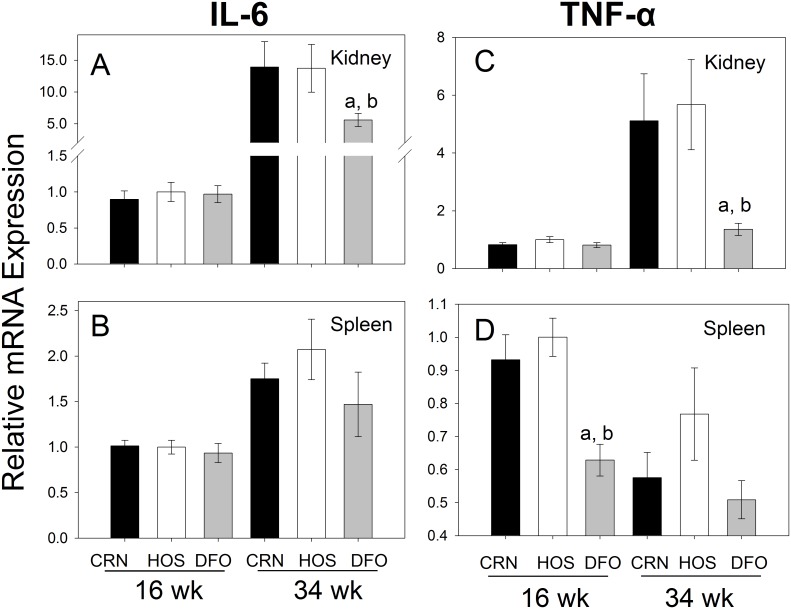
Differential effects of n-3, n-6 and n-9 PUFA consumption on IL-6 and TNF-α mRNA expression. Experiment conducted as described in Fig. 7 legend except that IL-6 (A, B) and TNF-α (C, D) mRNAs were measured by quantitative RT-PCR.